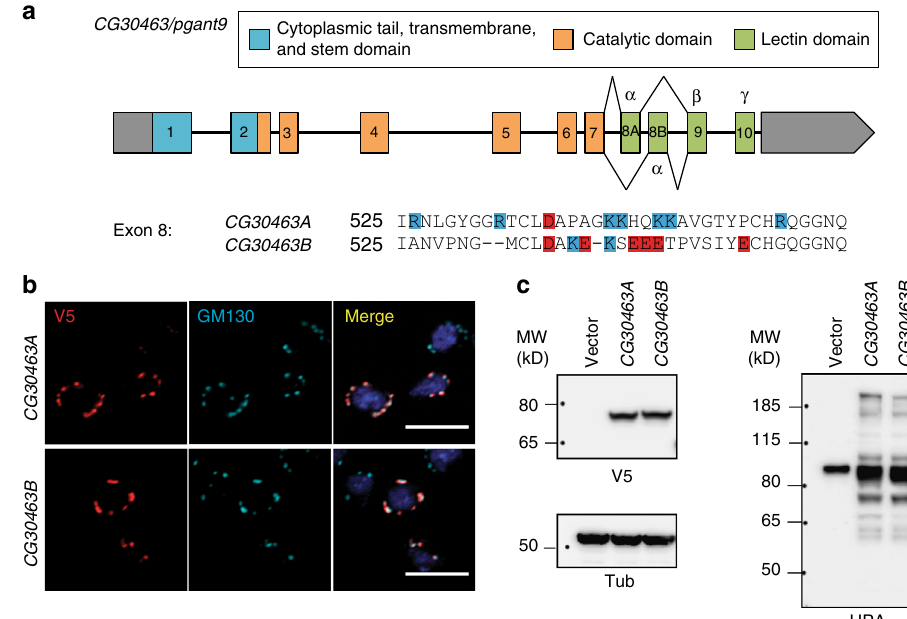
Fig. 2 CG30463/pgant9 encodes a Golgi-localized O-glycosyltransferase. a Gene structure for CG30463/pgant9 is shown, with boxes representing exons and lines representing introns. The N-terminal (blue), catalytic (orange) and lectin (green) domains of the putative glycosyltransferase encoded by CG30463 are shown. The lectin domain consists of three subdomains ( α , β , and γ ). The sequence for the differentially spliced α subdomain (exon 8) is shown, with acidic residues highlighted in red and basic residues highlighted in blue. b Both splice variants (V5-tagged; red) localized to the Golgi apparatus (as detected by anti-GM130; blue) in S2R + cells. Scale bar, 10 μ m. Representative images from two independent experiments are shown. c Western blots of S2R + cells expressing vector alone (Vector), a V5-tagged recombinant CG30463A or a V5-tagged recombinant CG30463B . Panels on the left show CG30463A and CG30463B expression with the V5-tag (anti-V5) and loading controls (anti-tubulin). Panel on the right shows increased O- glycosylation (as detected by the lectin HPA) when CG30463A or CG30463B are expressed in S2R + cells. Representative western blots from three independent experiments are shown. Molecular weight markers (kD) are shown to the left of each